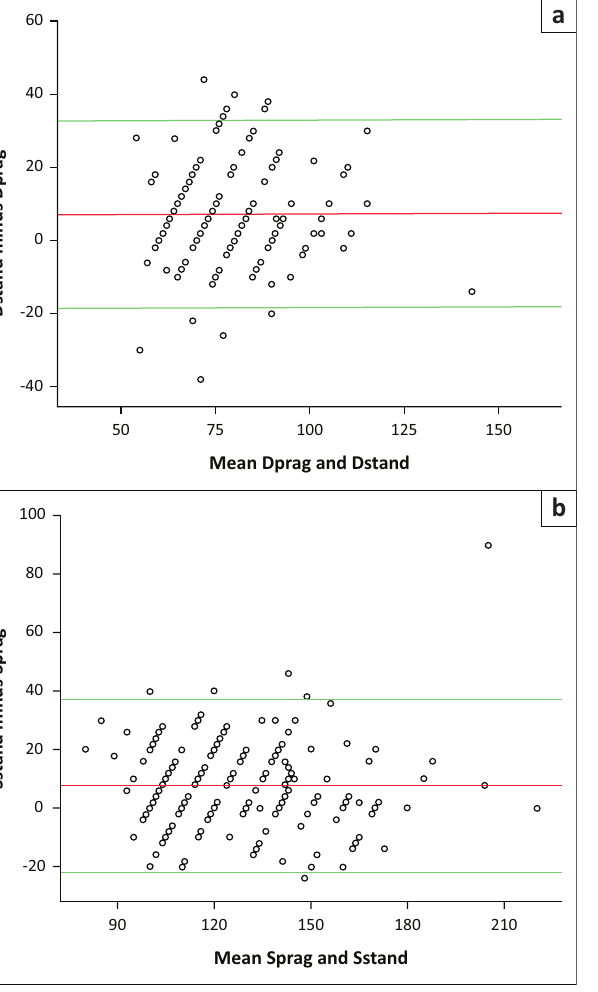
blood pressure. FIGURE 3: The Bland-Altman plot difference against the mean for (a) diastolic blood pressure and (b) systolic blood pressure – guideline-concordant compared to usual-care.